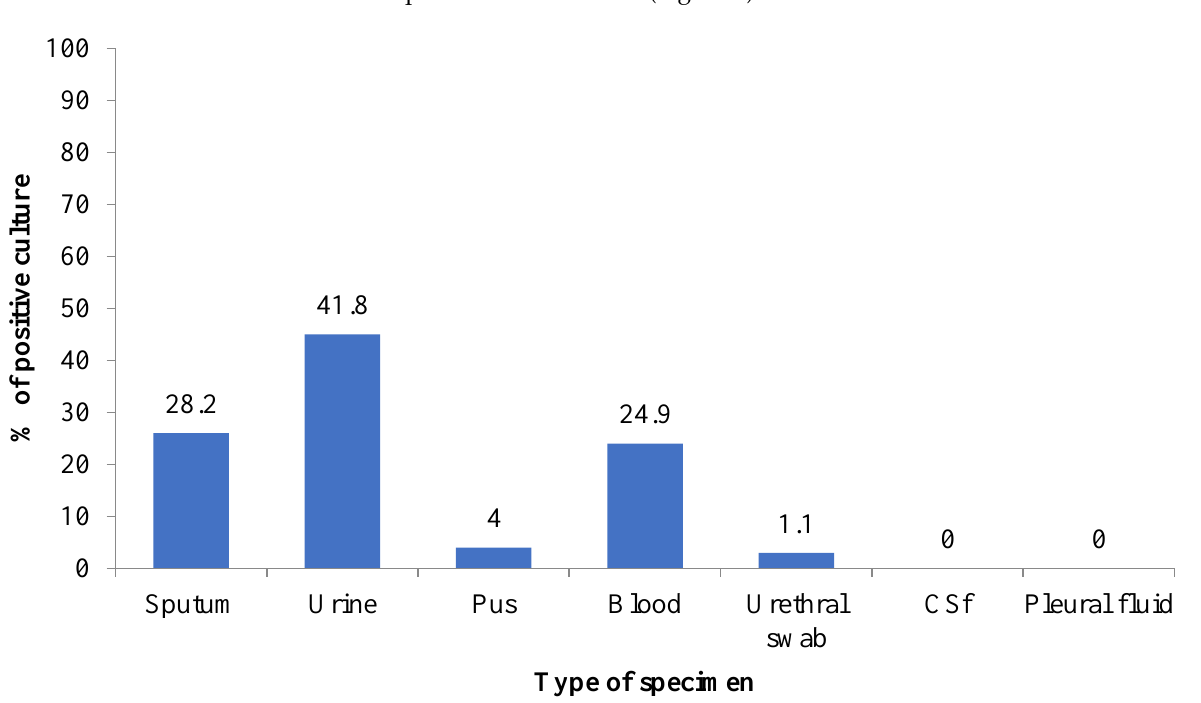
Figure 1. Bacterial growth status in clinical samples.